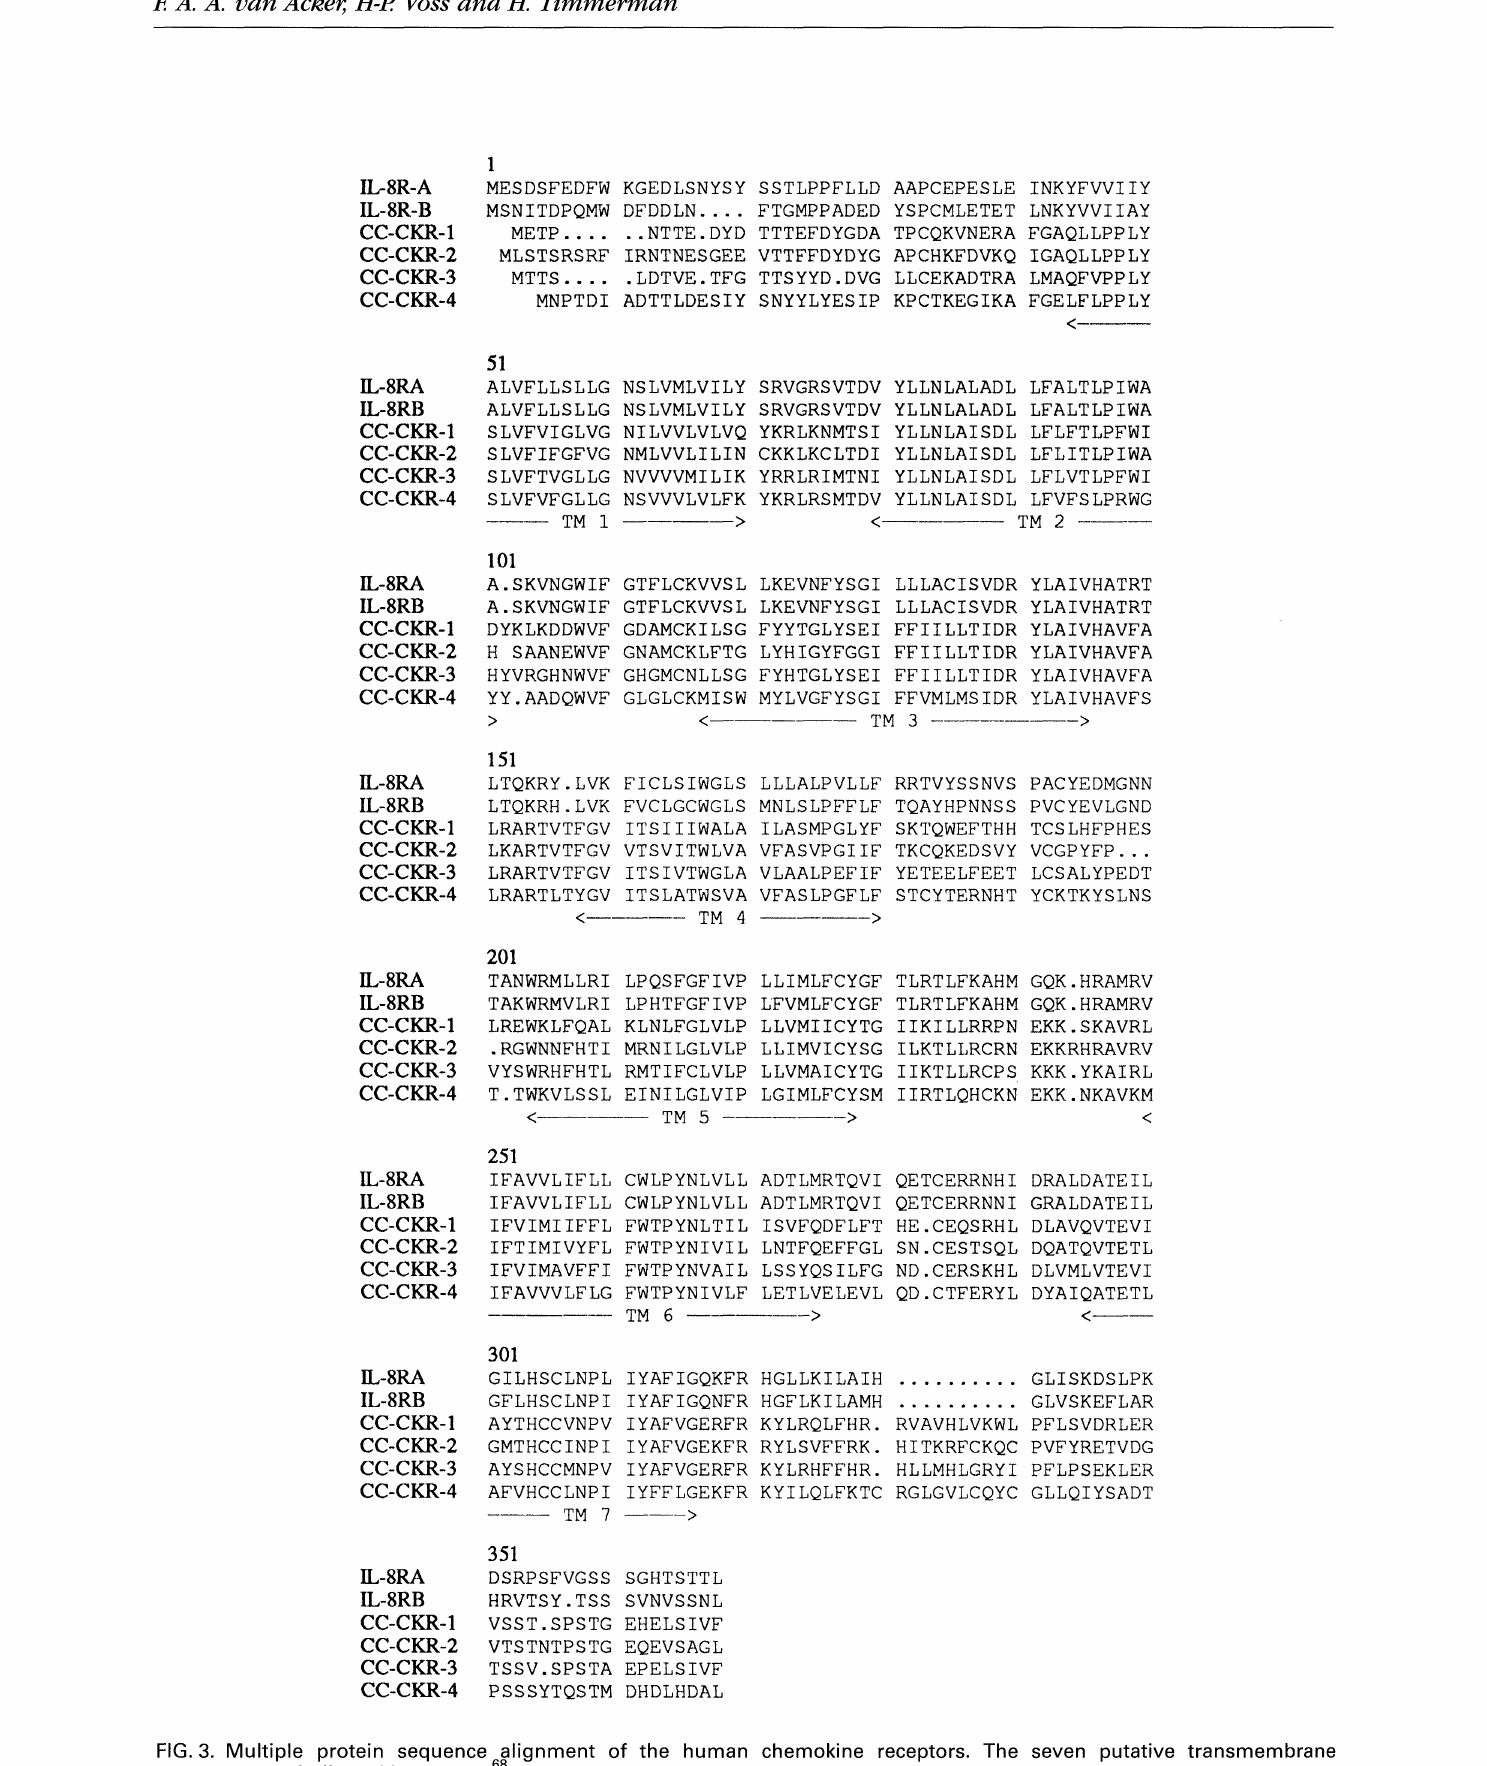
FIG. 3. Multiple protein sequence68alignment of the human chemokine receptors. The seven putative transmembrane sequences are indicated by arrows. 400 Mediators of Inflammation Vol 5